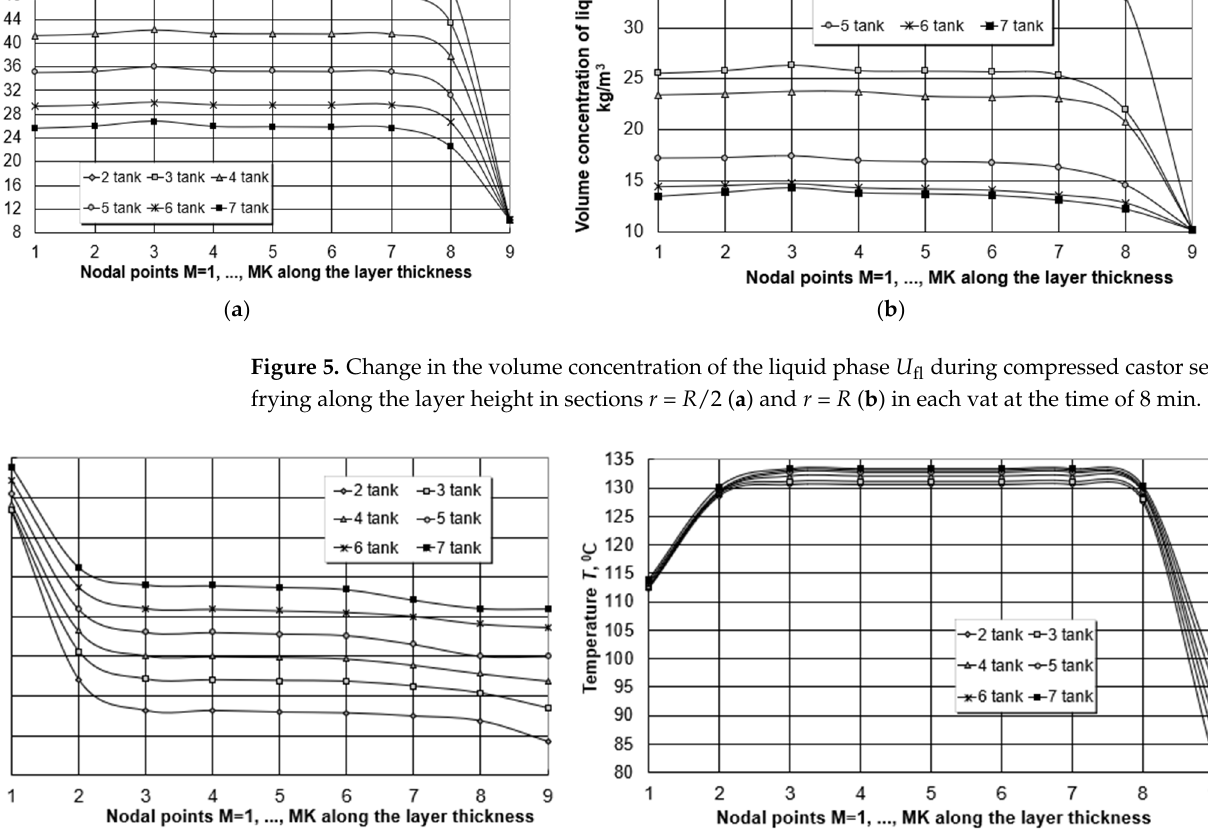
Figure 5. Change in the volume concentration of the liquid phase U fl during compressed castor seed frying along the layer height in sections r = R /2 ( а ) and r = R ( b ) in each vat at the time of 8 min.